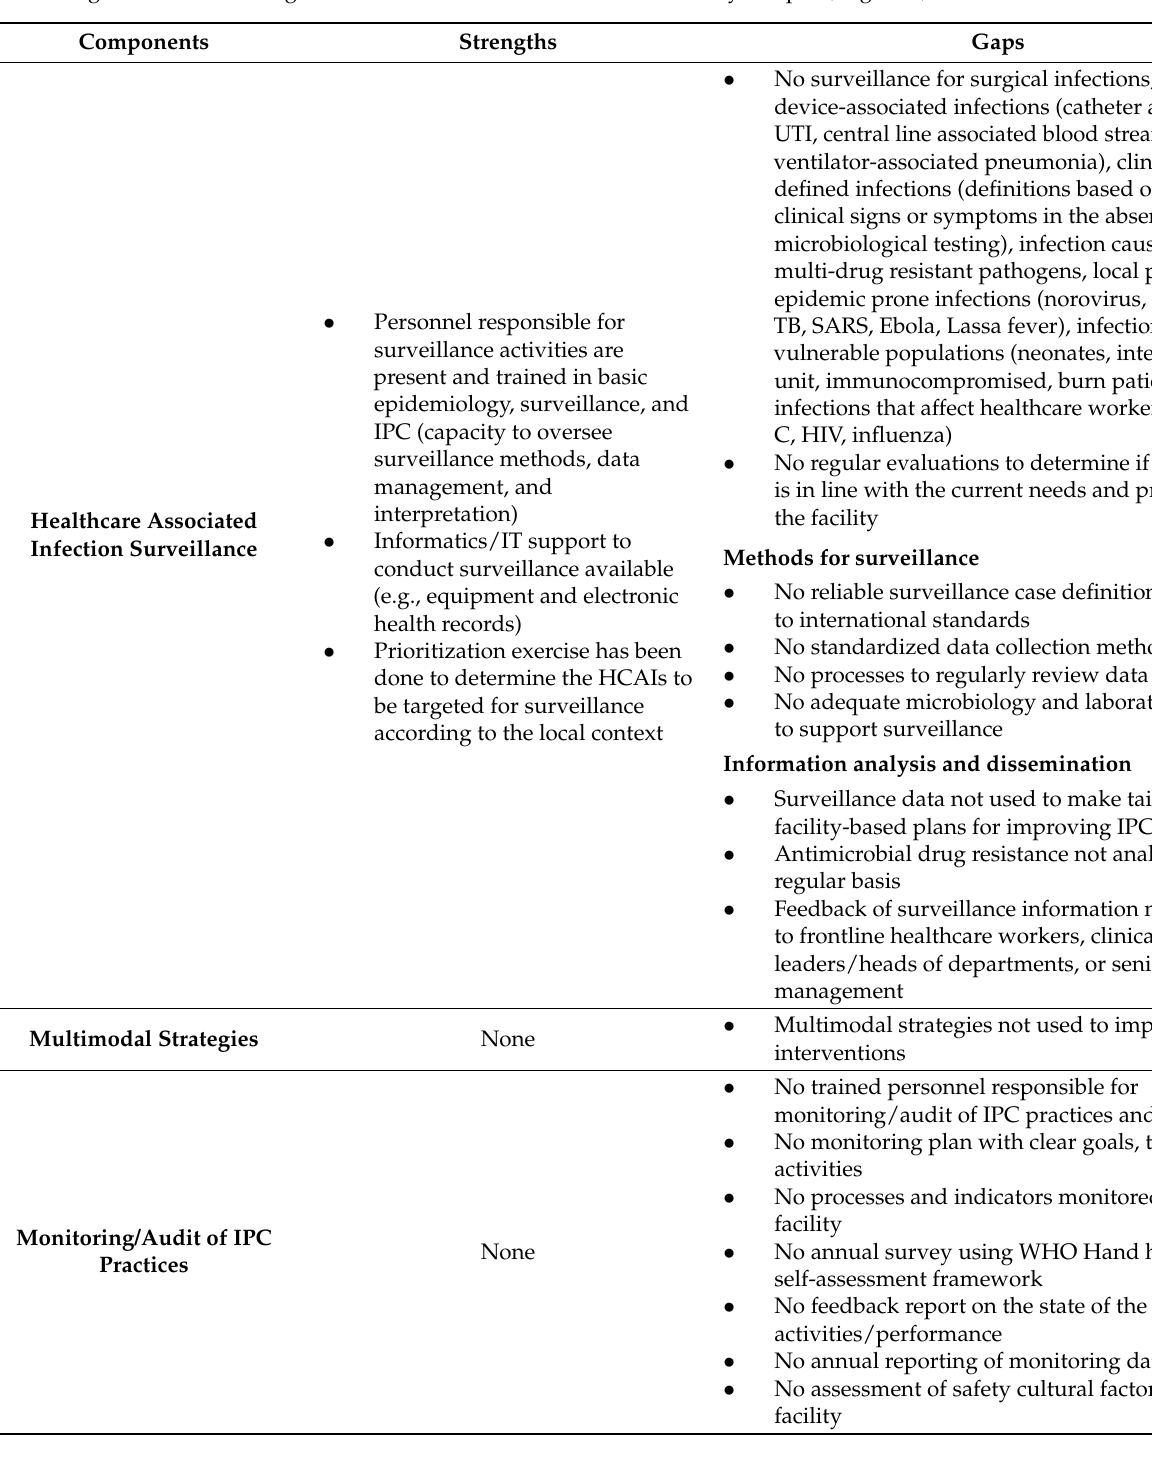
Table 4. Strengths and gaps in IPC (infection prevention and control) surveillance, monitoring, audit, and multimodal strategies observed during a baseline IPC assessment at Lira University Hospital, Uganda, in November